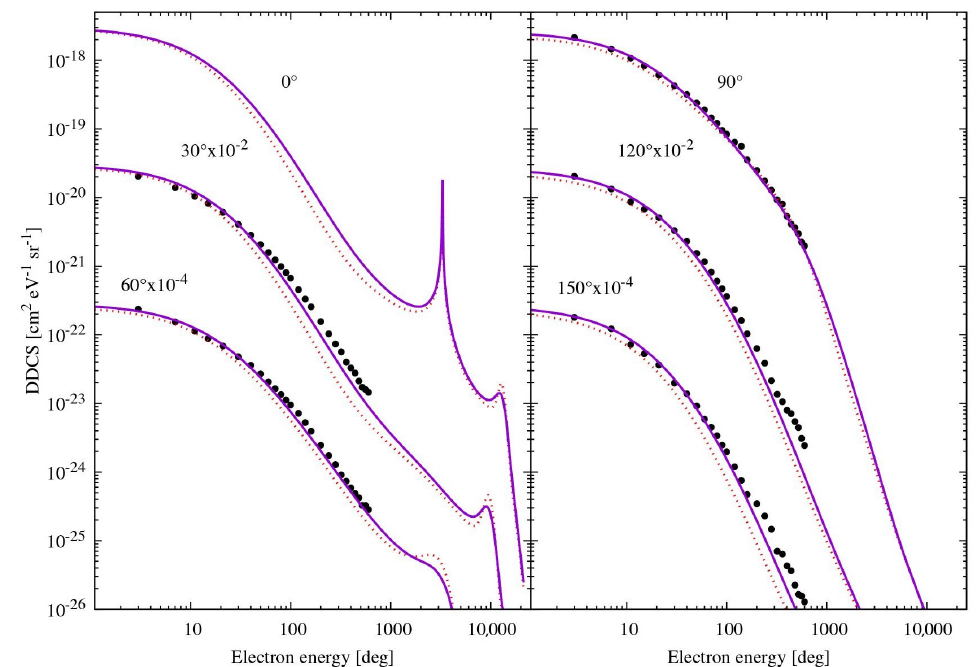
Figure 4. Same as Figure 3, but for the ionization of Ne